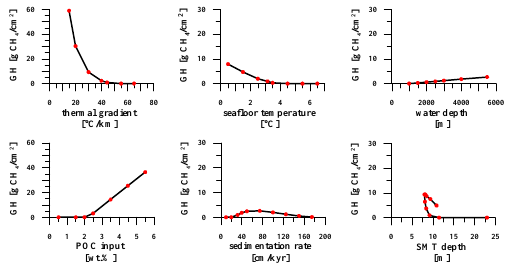
Fig. 8. Effect of the POC initial age (age init ) on the accumulation of gas hydrates in marine sediments at two different sedimentation Figure 8. Effect of the POC initial age ( age init ) on the accumulation of gas hydrates in marine rates ( ω) . sediments at two different sedimentation rates ( ω ).